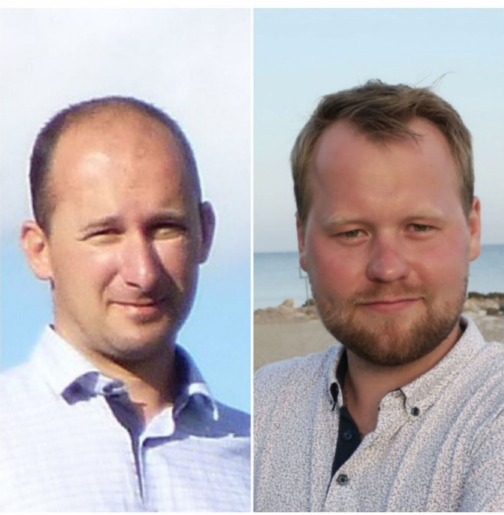
Figure 2. Dr Vojtˇech Biolek ( left ) and Tomáš Hanák ( right